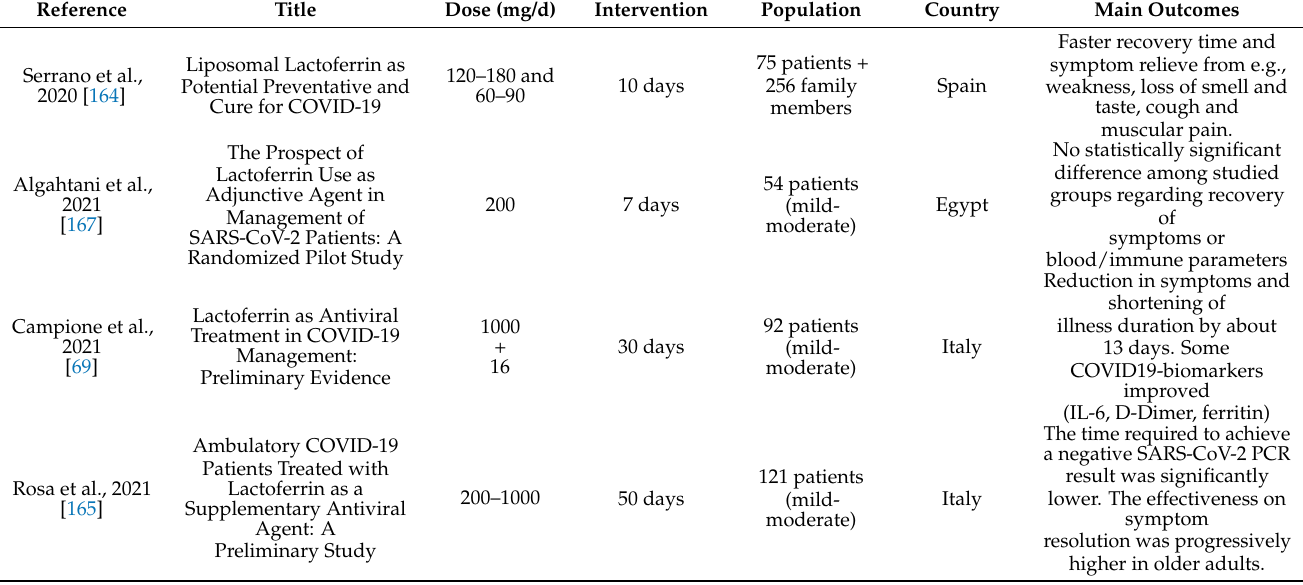
Table 5. LF intervention trials in COVID-19